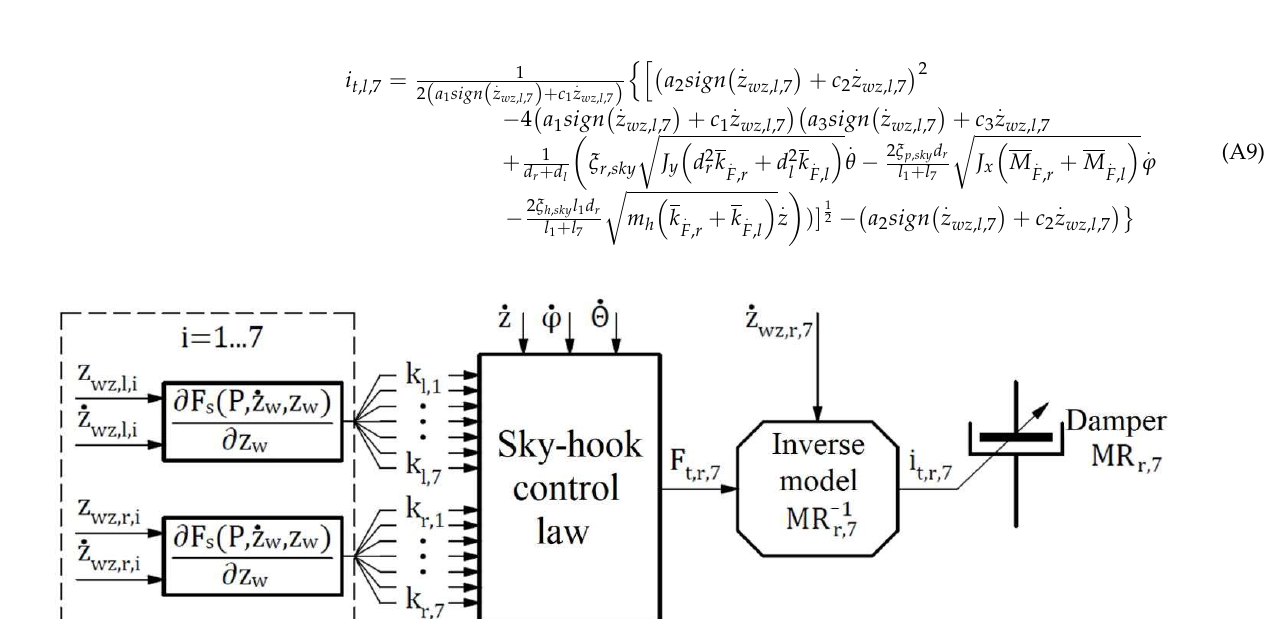
Figure A1. The control law for the magnetorheological damper on the right side and the seventh axis (MR r,7 ). Figure A2. The control law for the magnetorheological damper on the left side and the first axis (MR l,1 ).